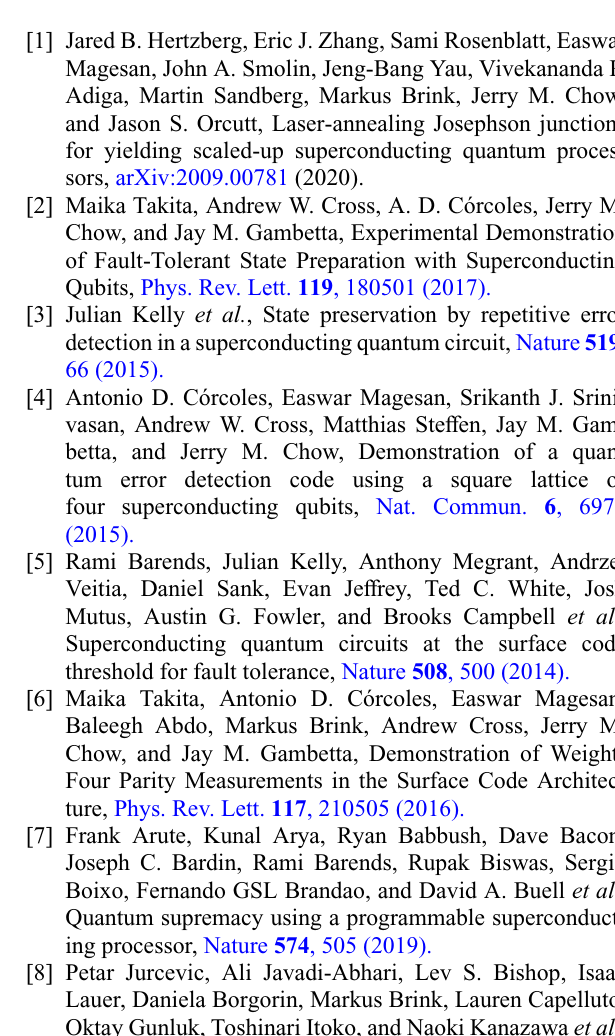
Algorithm 2. Calibration of CCR drive duration